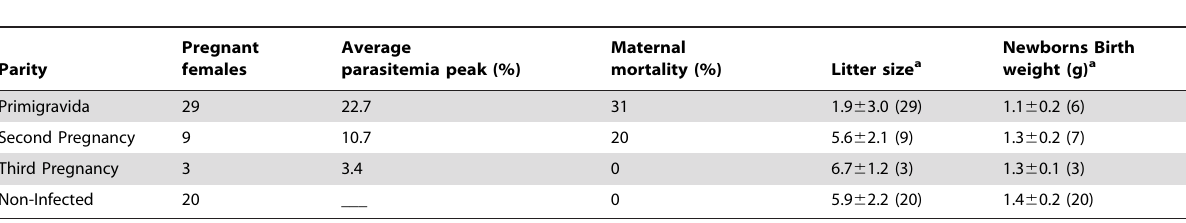
Table 1. Disease severity and pregnancy outcome in P. berghei recrudescent females according to parity.